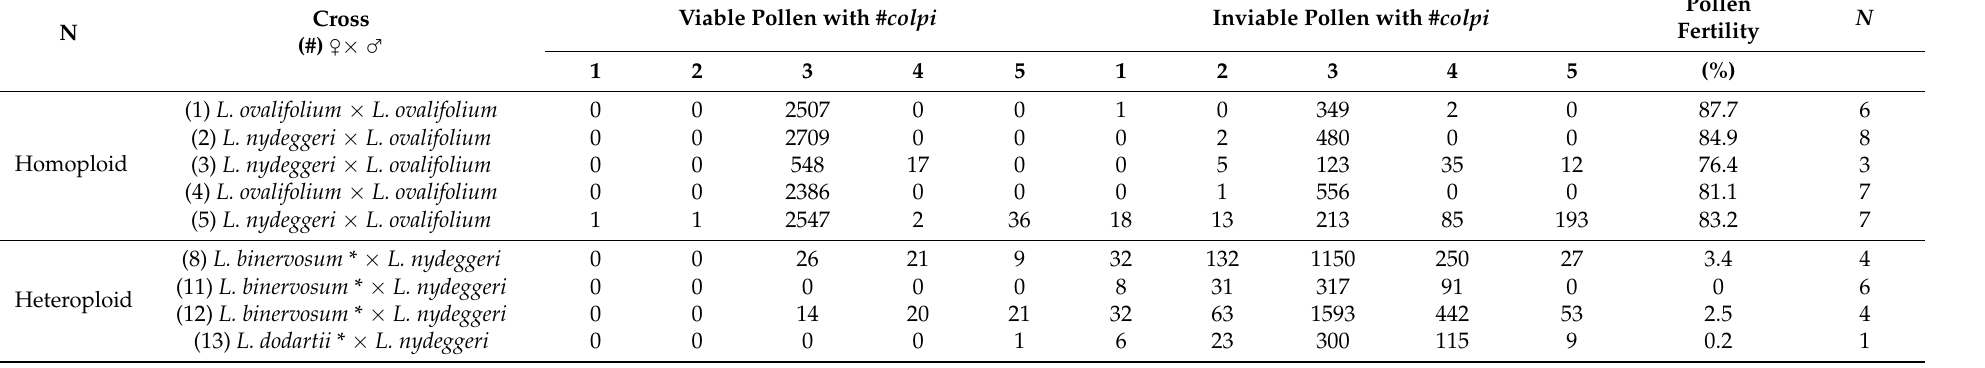
Table 3. Number of pollen grain types and percentage of pollen viability observed in plants obtained in homoploid (diploid × diploid) and heteroploid (tetraploid × diploid) crosses. The data on species and on experimental crosses were derived from [4]. The species marked with an asterisk (*) reproduced by apomixis [4]. N represents the number of individuals/cross analyzed. Symbols: